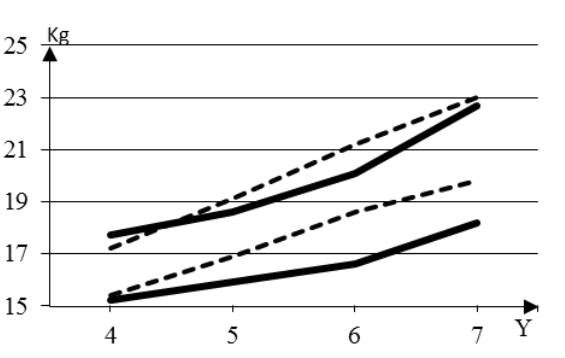
Fig. 5. Dynamic of left hand dynamometry indicators’ change (Dp, Kg) from Y (Y, years)